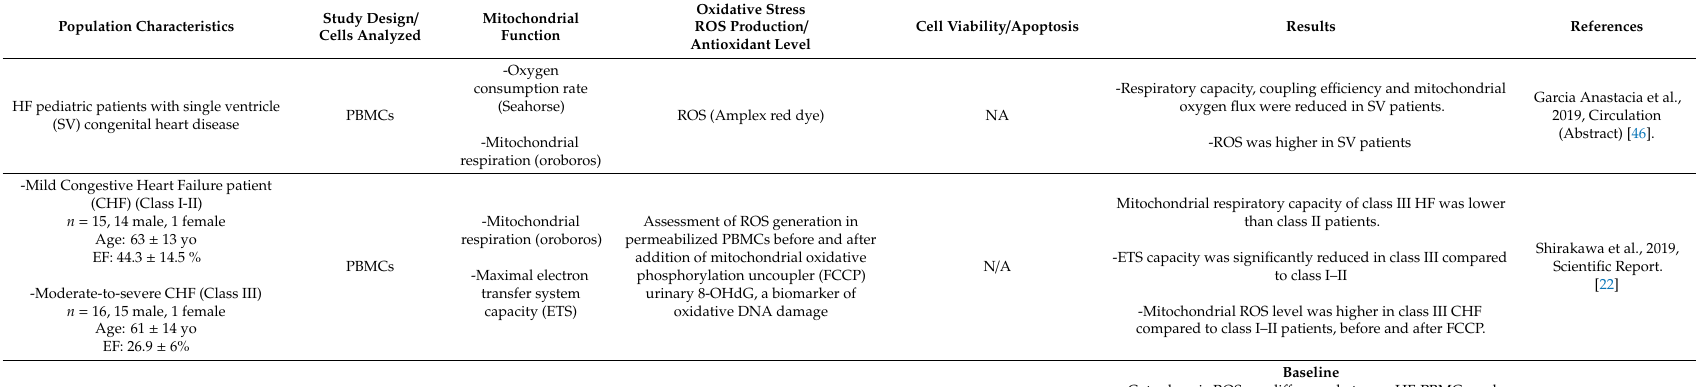
Table 1. Mitochondrial function, oxidative stress, and apoptosis in circulating blood cells during cardiovascular